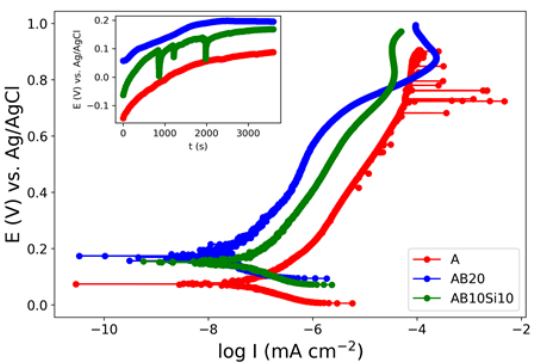
Figure 1. Potentiodynamic polarization curves of as-quenched A, AB20, and AB10Si10 ribbons in 3 wt.% NaCl. The inset show the evolution with time of the OCP.